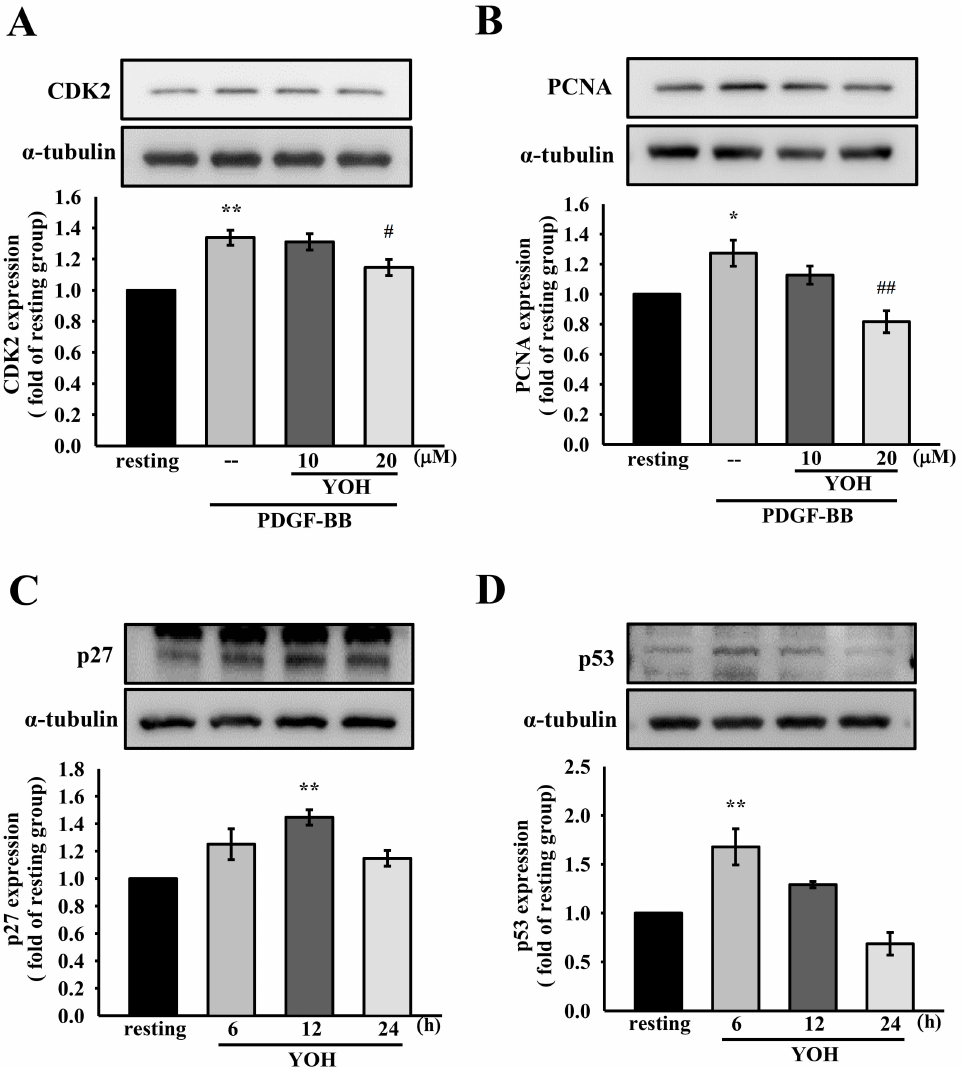
Figure 3. YOH suppresses expression of PDGF-BB-induced CDK2 and PCNA and upregulates expression of p27Kip1 and p53 in MOVAS-1 cells. MOVAS-1 cells were incubated with YOH (10 or 20 µ M) for 45 min and treated with ( A , B ) or without ( C , D ) PDGF-BB stimulation (10 ng/mL). Protein expression levels of ( A ) CDK2, ( B ) PCNA, ( C ) p27Kip1, and ( D ) p53 were determined through Western blotting, as described in the Materials and Methods section. * p < 0.05, ** p < 0.01 compared with the resting group; # p < 0.05, ## p < 0.01 compared with the positive group. Data are presented as the mean ± S.E.M. ( n =